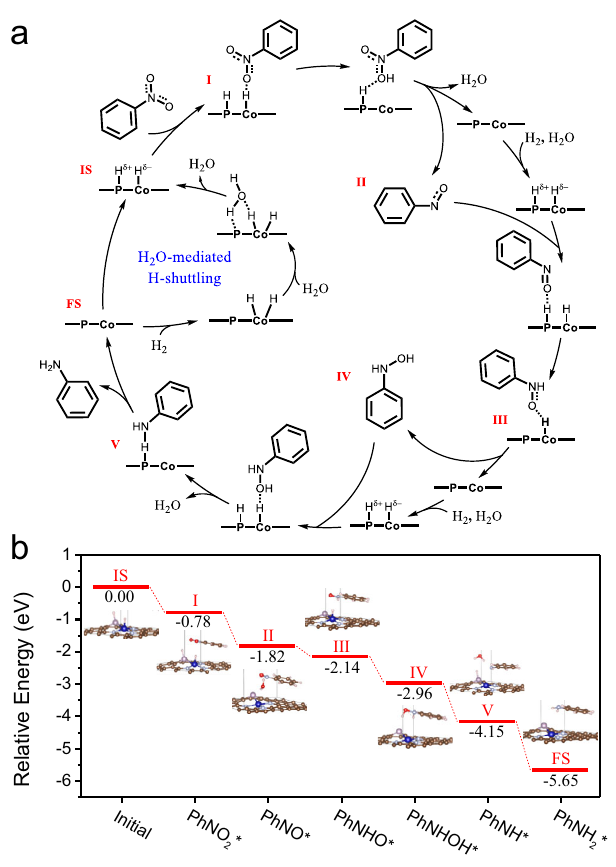
Fig. 5 Reaction mechanism of the nitrobenzene reduction. a The proposed reaction pathway for the hydrogenation of nitrobenzene to aniline at Co-P interface site. b Energy pro fi le of hydrogenation of nitrobenzene over Co 1 - N 3 P 1 site.